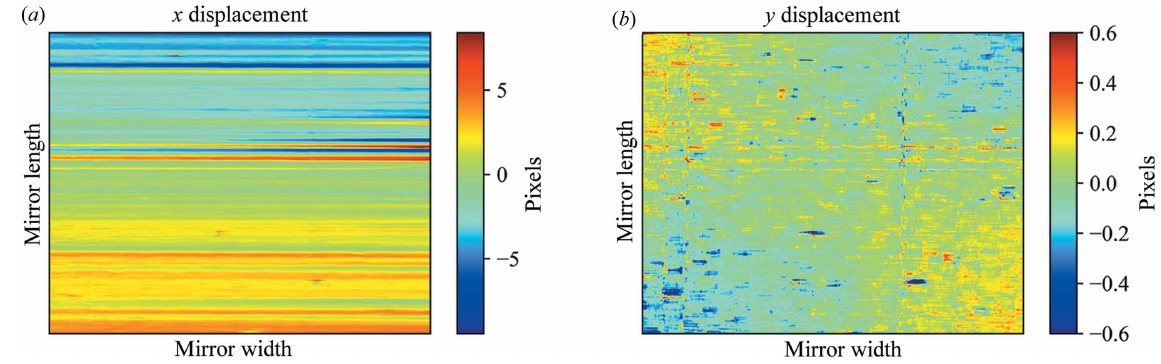
Figure 4 Rotation-corrected 2D map of the displacement in the ( a ) x and ( b ) y directions. The y displacement map ( b ) has none of the large-scale artificial low- spatial-frequency features derived from the rotational misalignment observed in Fig. 2( b ). The x displacement was used to calculate the wavefront slope error.